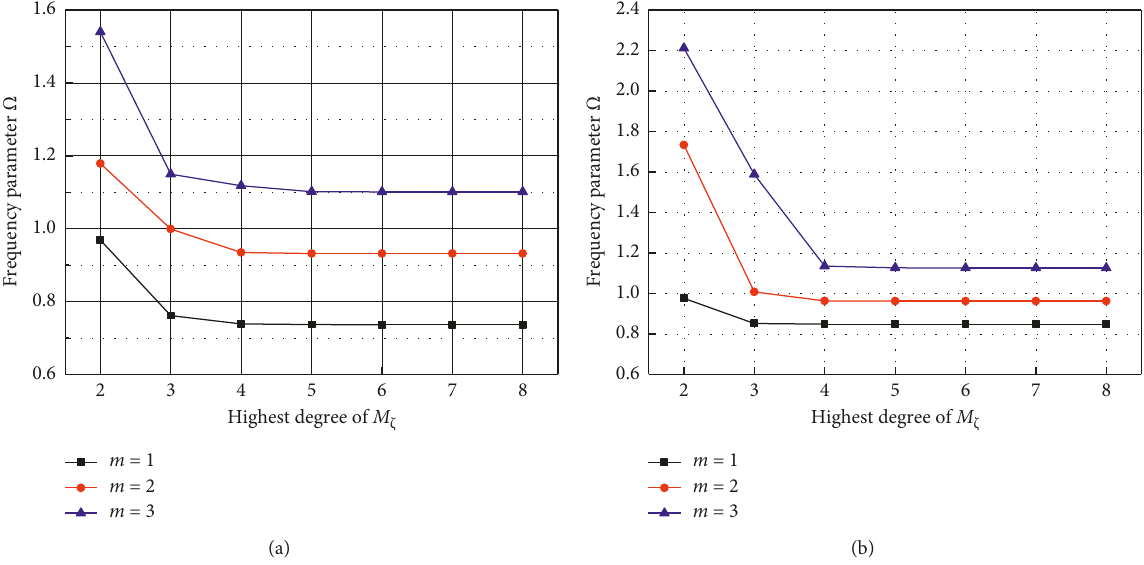
Figure 7: Frequency parameters